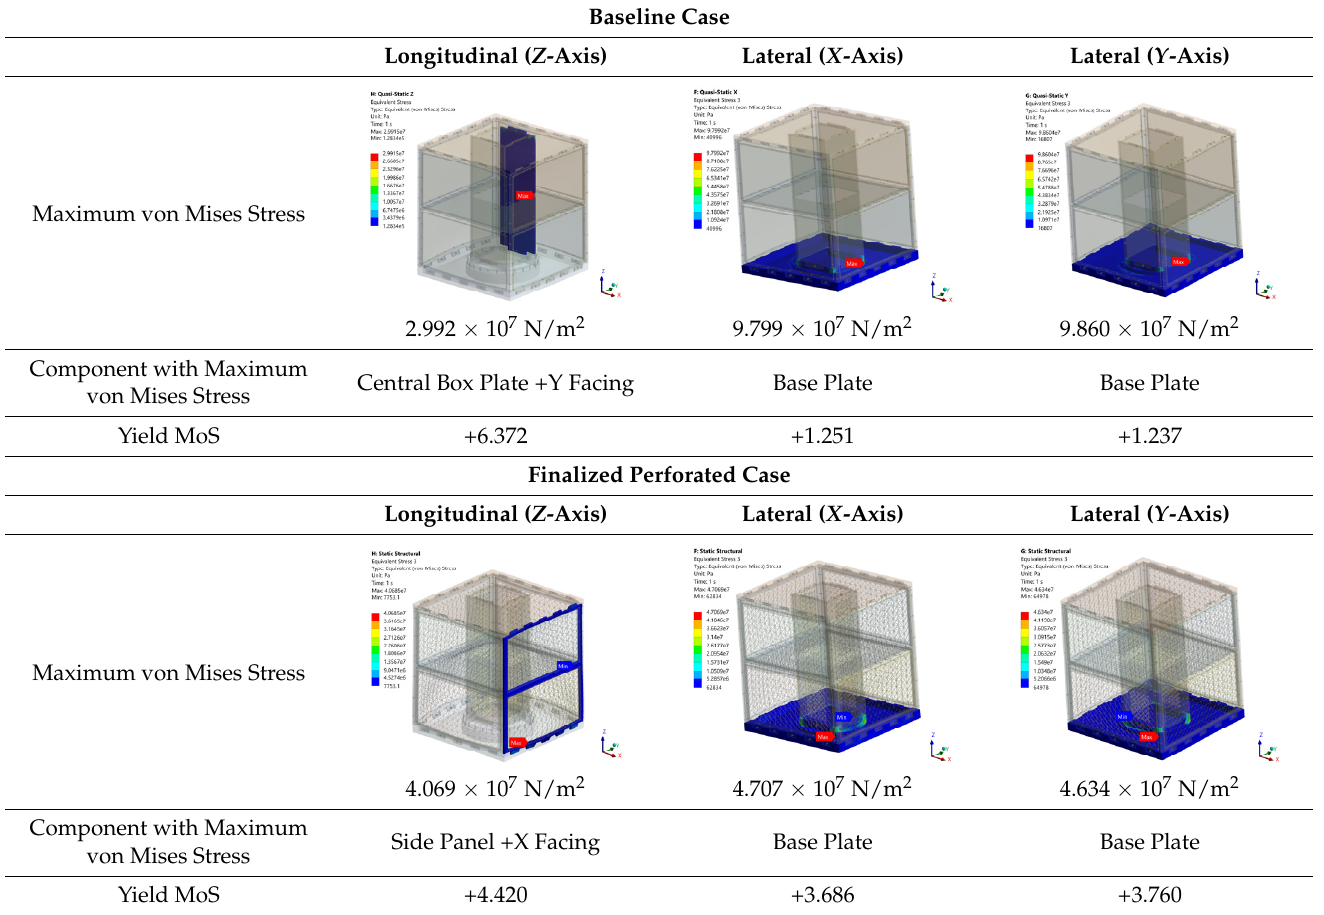
Table 4. Baseline and perforated quasi-static launch loads—maximum von Mises stresses.